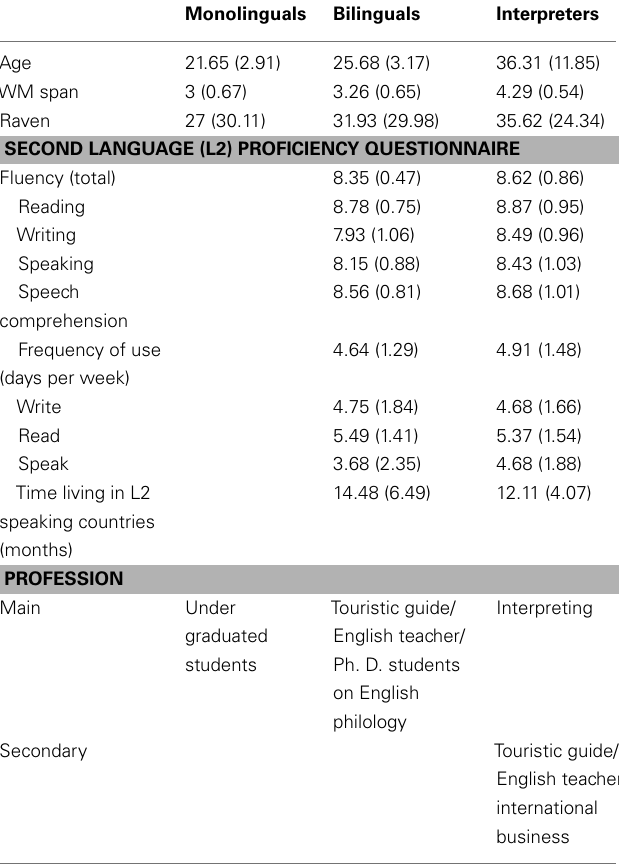
Table 1 | Characteristics of participants in the